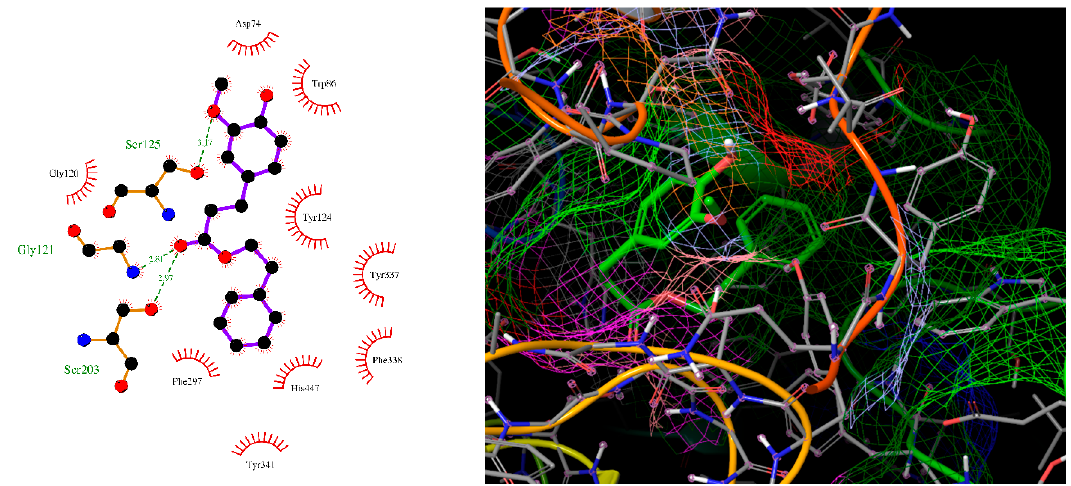
Figure 2. Hydroferulic acid phenethyl ester 4 with AChE (PDB: 4EY4) ( left : Hydrogen bonds with Ligplot + ; right : 3D image with Maestro).